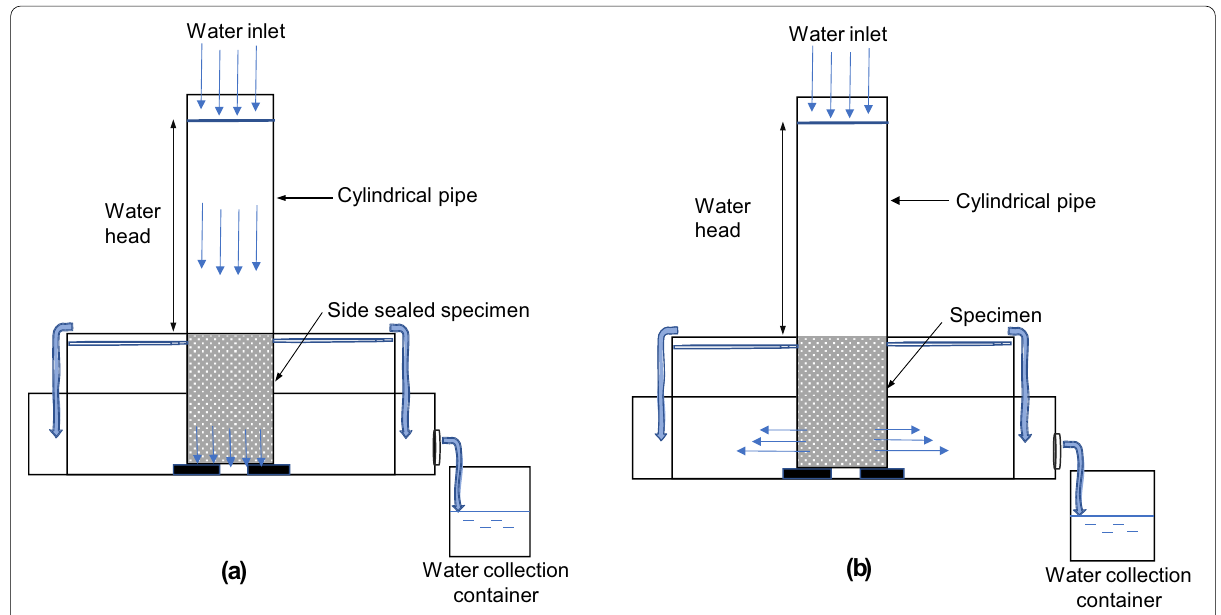
Fig. 6 Schematic of the constant head test method: a vertical; and b horizontal (EN